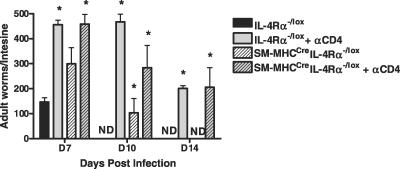
TH2 Cytokine Responses Are Impaired in SM-MHCCreIL-4Rα−/lox MiceMice were injected IP with depleting anti-CD4 antibody 3 d before infection and subsequently every 4 d. Intestinal worm counts were examined at days 7, 10, and 14 PI in IL-4Rα−/lox mice and SM-MHCCreIL-4Rα−/lox mice. *Significant differences compared to IL-4Rα−/lox mice (p < 0.05); data are representative of a single experiment.